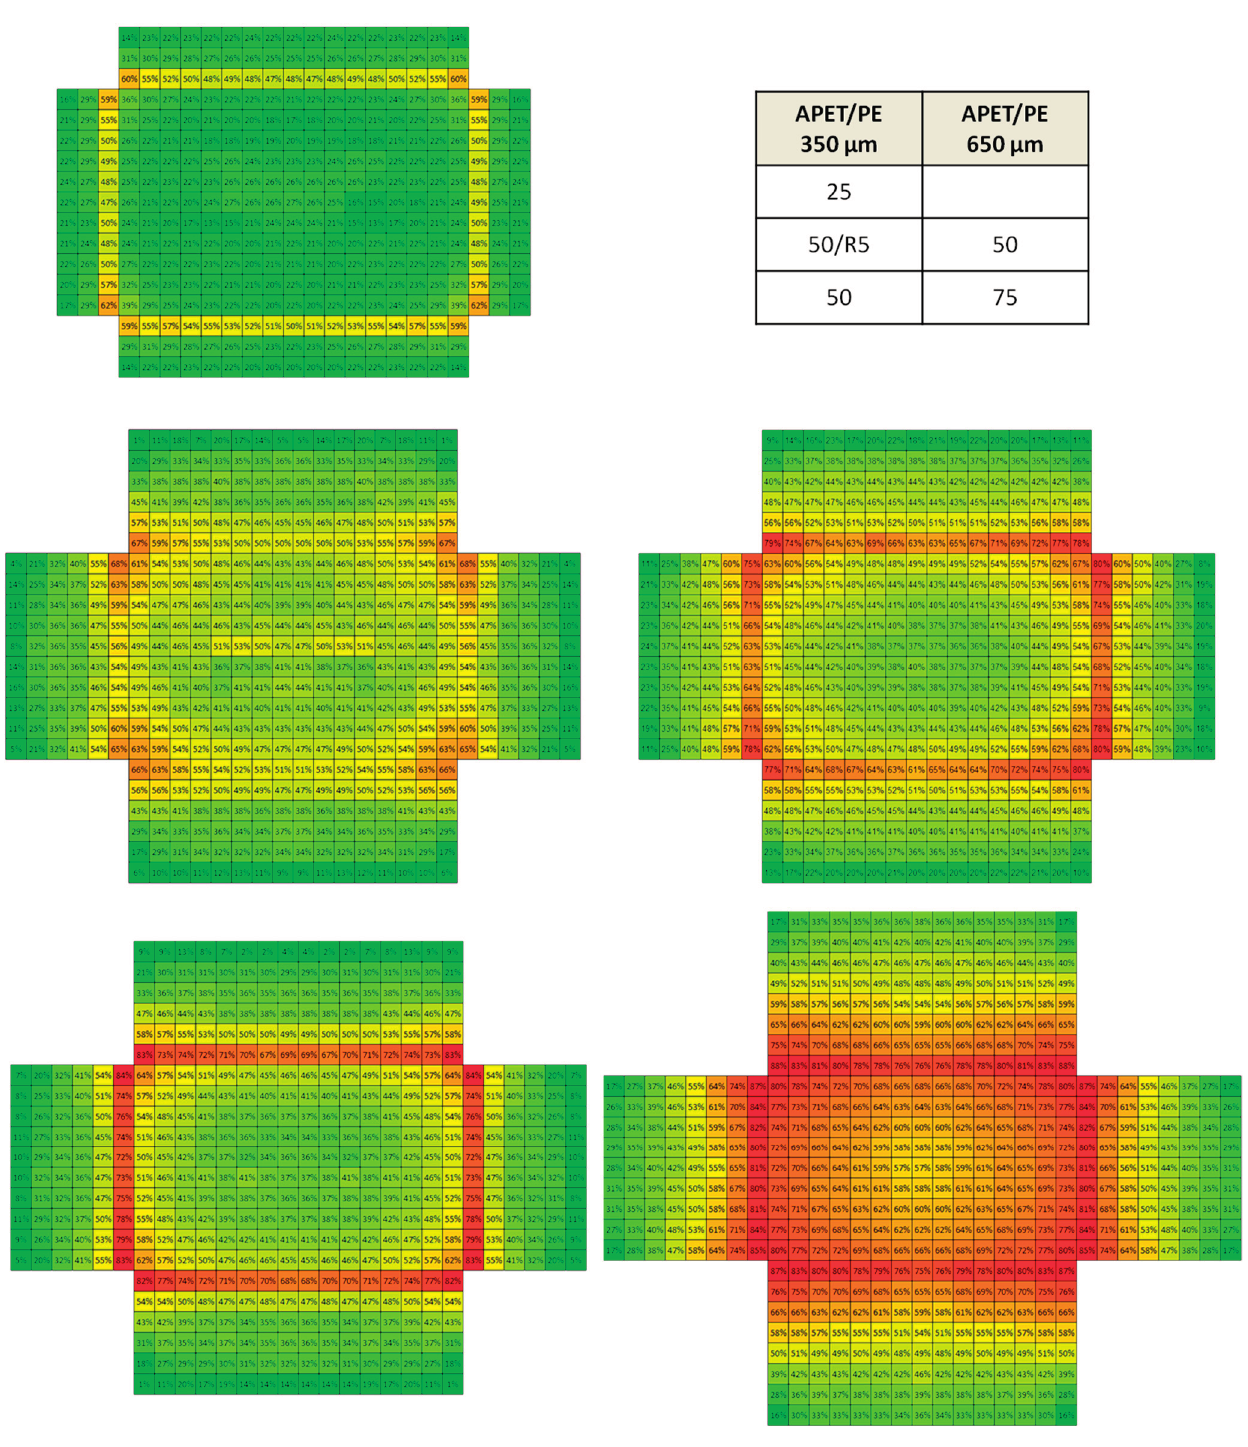
Figure 3. Visual representation of percentage thinning in 25-, 50/R5-, 50-, and 75-trays of the thin ( left ) and thicker ( right ) APET/PE